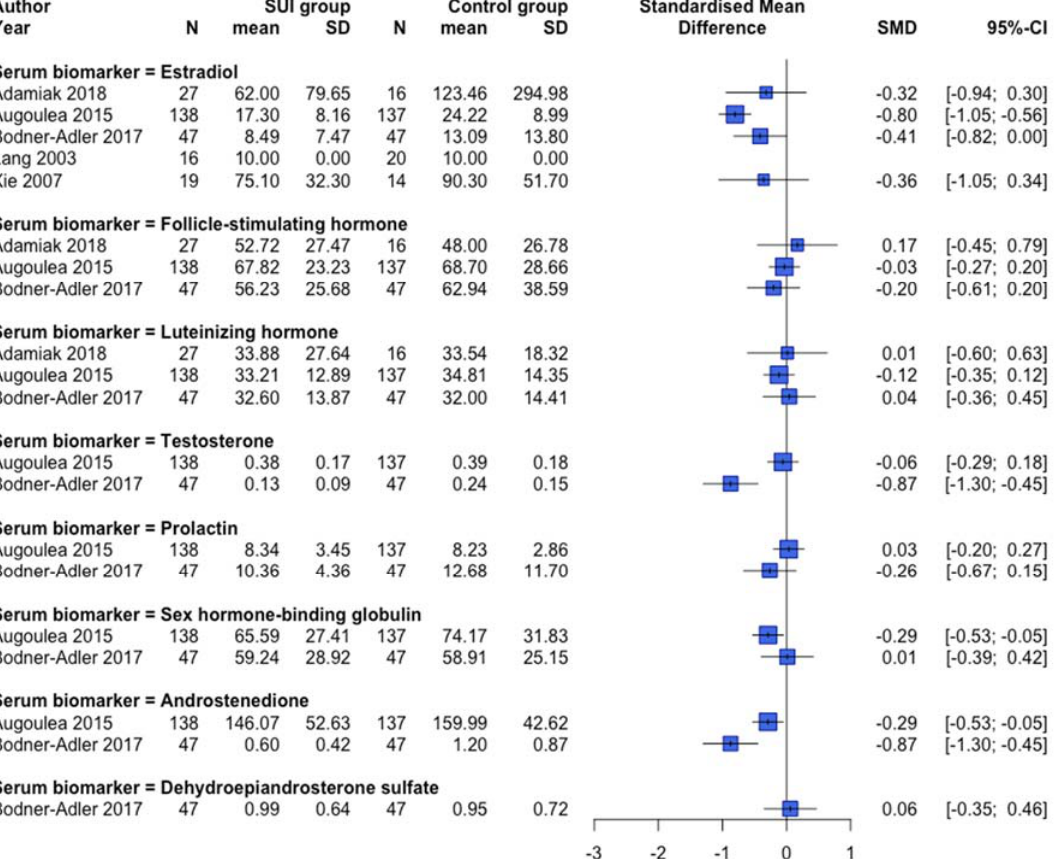
Figure 8. Forest plot of hormonal biomarkers in the serum of postmenopausal women. This forest plot shows differences in hormonal biomarkers in the serum between postmenopausal patients with SUI and controls, subdivided per hormone. Abbreviations: CI confidence interval, N number, SD standard deviation, SMD standardized mean difference, SUI stress urinary incontinence.